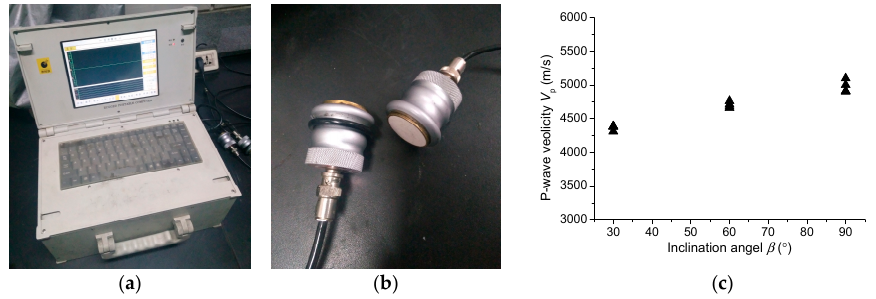
Figure 2. ( a ) NM-3C ultrasonic wave monitoring system; ( b ) transduces and ( c ) variation of P-wave velocities of these samples. Table 1. Geometrical and physical properties of the shale samples.